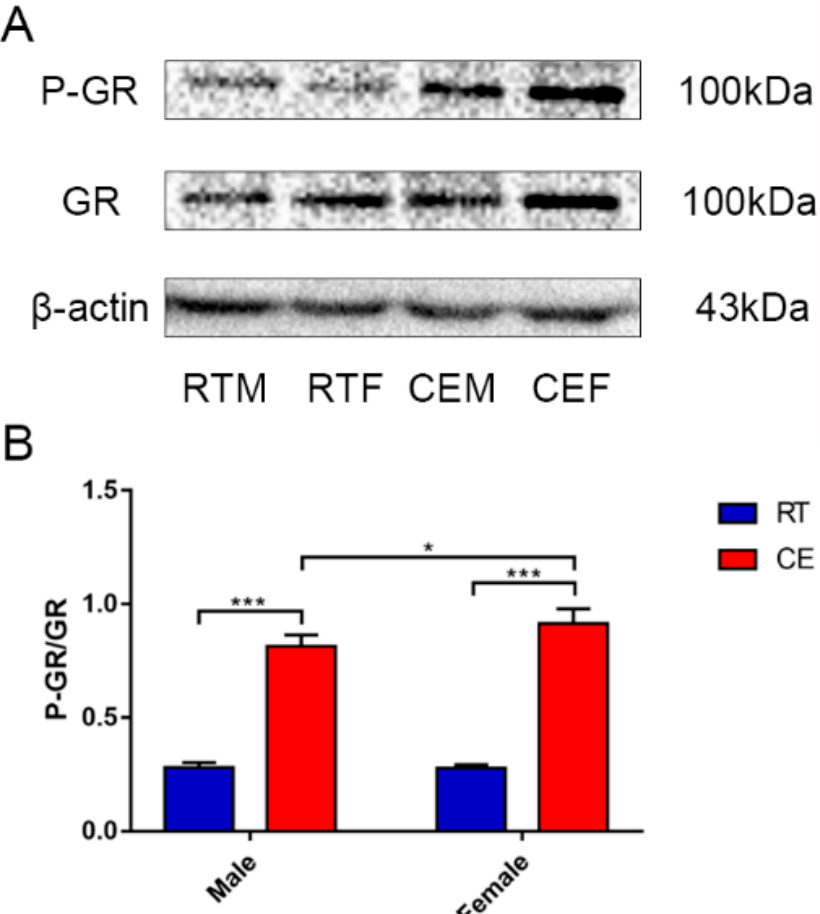
Figure 1. The relevant expression of the glucocorticoid receptor (GR) and phospho(P)-GR ( A ), and β -actin expression in hippocampus lysates as assessed by western blotting in each group. Expression levels were quantitated by measuring band intensities using Image Lab software. The graphs indicate the results of densitometric analyses using the expression ratios of ( B ) P-GR / GR. Data were between room temperature male vs. cold exposure male (CEM), room temperature female vs. cold exposure female (CEF), and CEM vs. CEF, and were analyzed by two-way analysis of variance. The results are expressed as the mean ± SD (n = 6) of four independent experiments analyzed by two-way analysis of variance. * p < 0.05; *** p < 0.001.